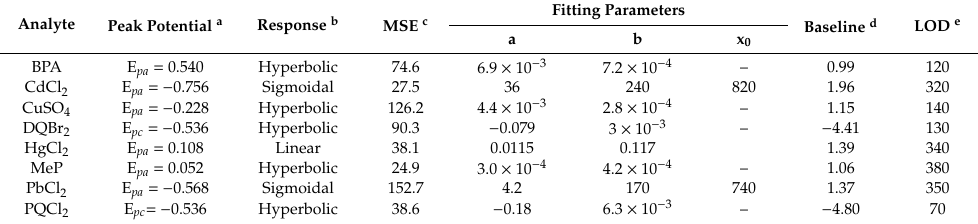
Table 1. Analysis and fitting parameters of the dose response for each analyte.